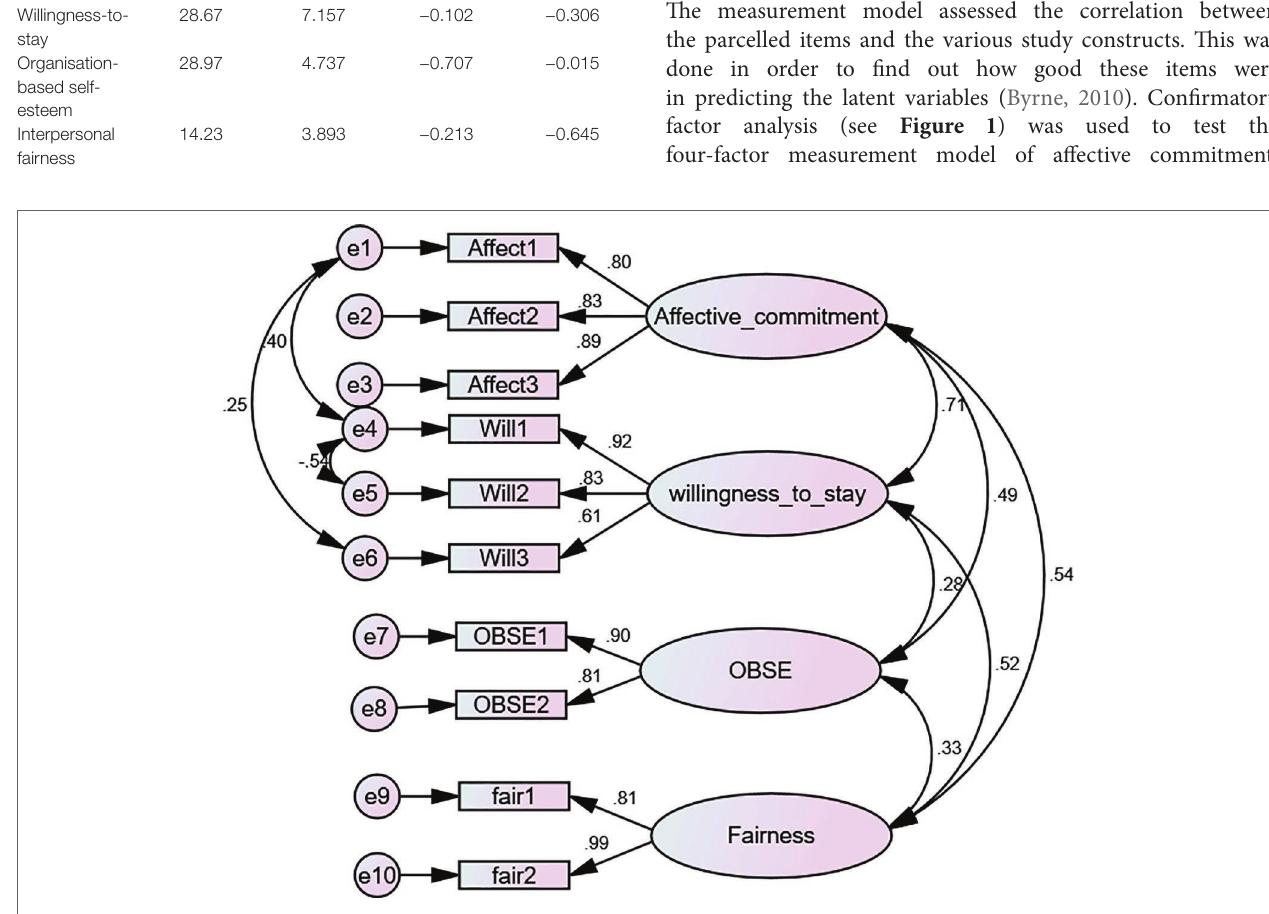
FIGURE 1 | CFA model showing the factor loadings and covariance among the study variables.